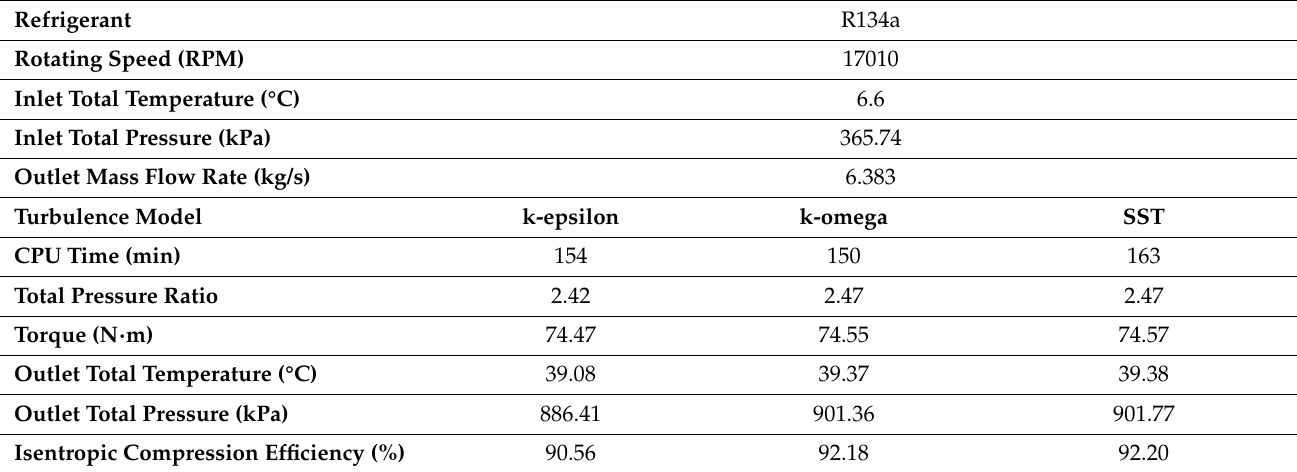
Table 4. Comparison of the results from different turbulence models.